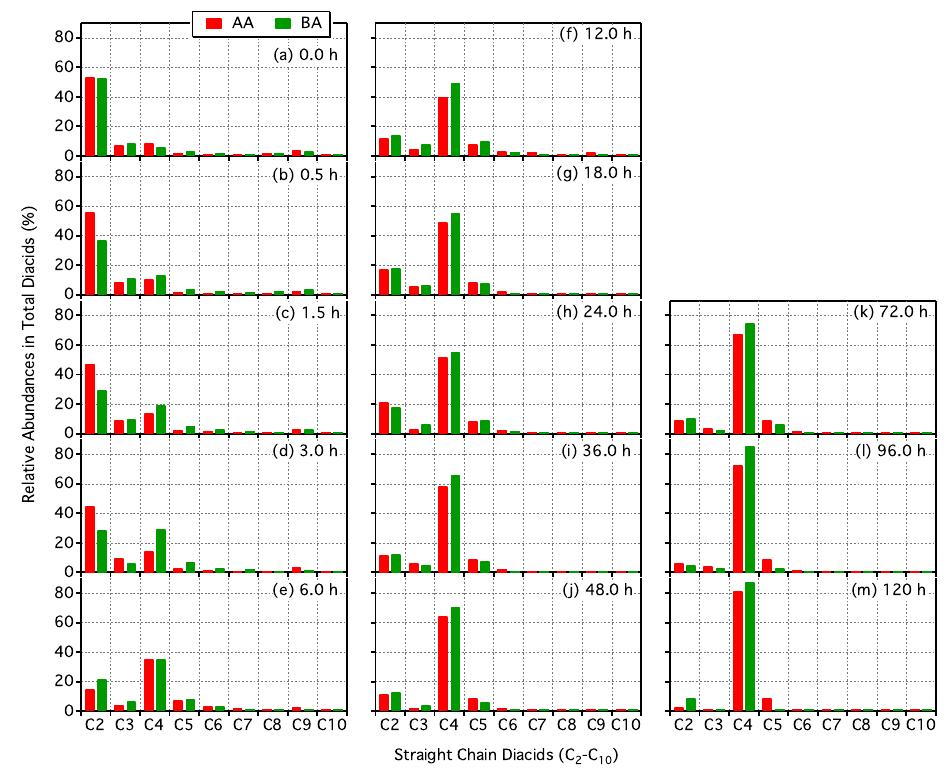
Figure 5. Changes in relative abundances of straight-chain diacids (C 2 –C 10 ) to total diacids as a function of UV irradiation time in AA and